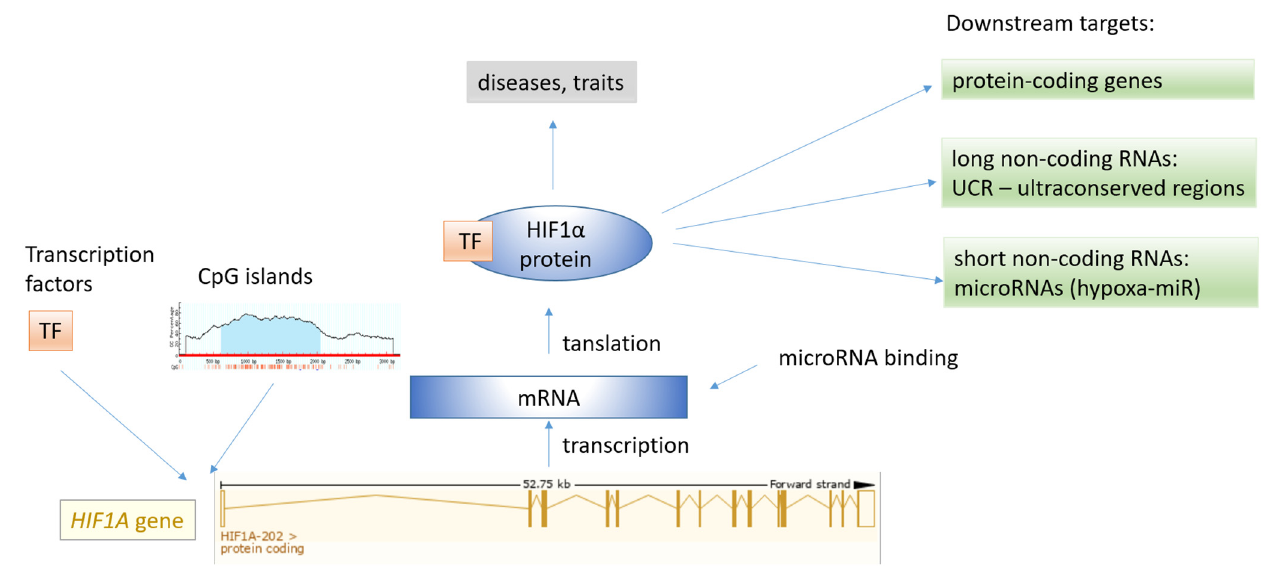
Figure 6. The map of regulatory elements associated with the HIF transcription factor family. The HIF1A gene structure was obtained from the Ensembl genome browser.